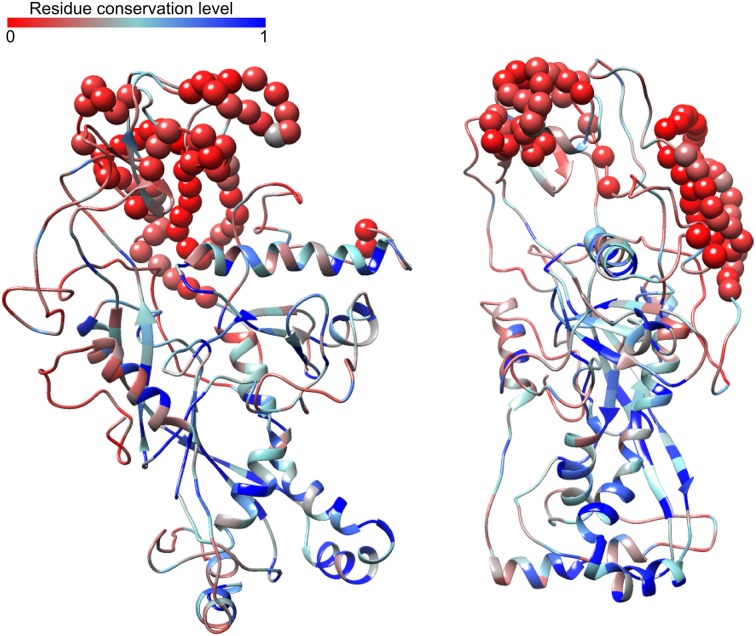
Predicted structure of the Far-T4 major capsid protein (two views rotated by 90° through the y-axis). This model is based on the sequence from contig Pavin_2013_4m_8, and was predicted with I-Tasser based on the structure of the T4 phage vertex protein. Models are colored according to their conservation across T4-like phages, from least (red) to most (blue) conserved. Residues corresponding to insertions in the Far-T4 sequence not present in other T4 phages are highlighted with spheres.